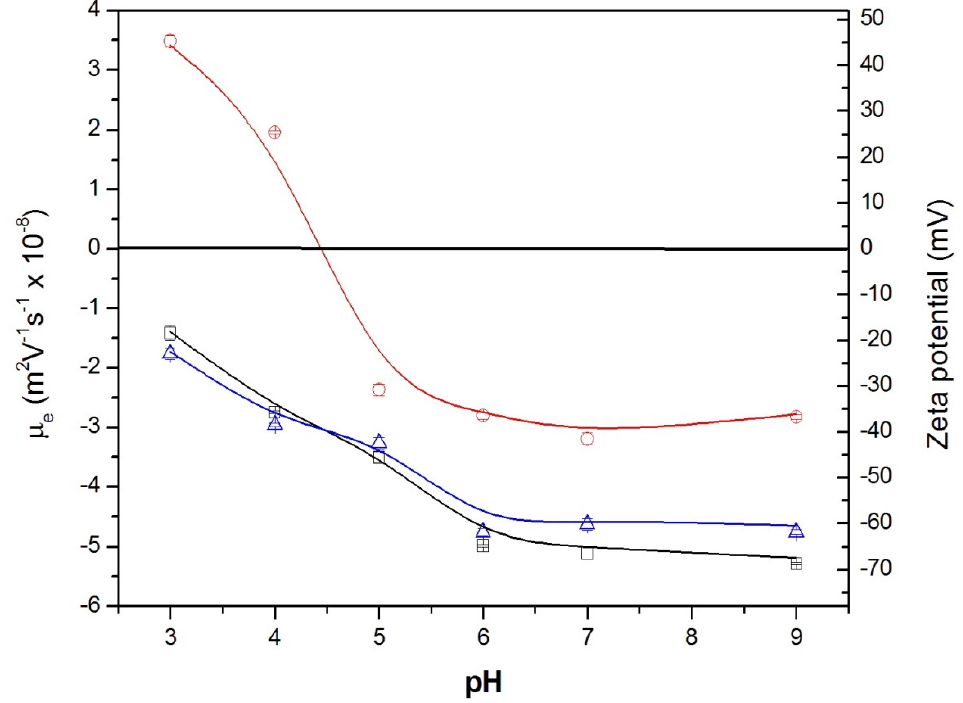
Figure 4. Electrophoretic mobility and zeta potential vs. pH in bu ff ered media of low salinity (ionic strength equal to 0.002 M) for the di ff erent nanosystems: (black square) NP; (blue triangle) NP-BMP2; (red circle) NP-BSA-BMP2.